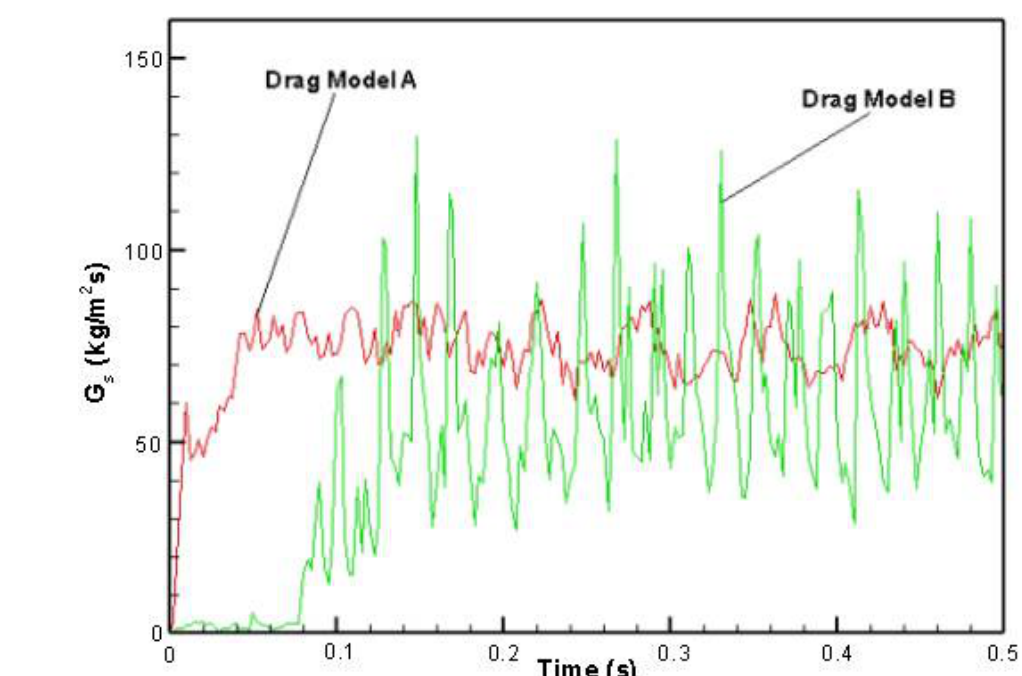
Figure 7. Sectional particle velocity distributions.